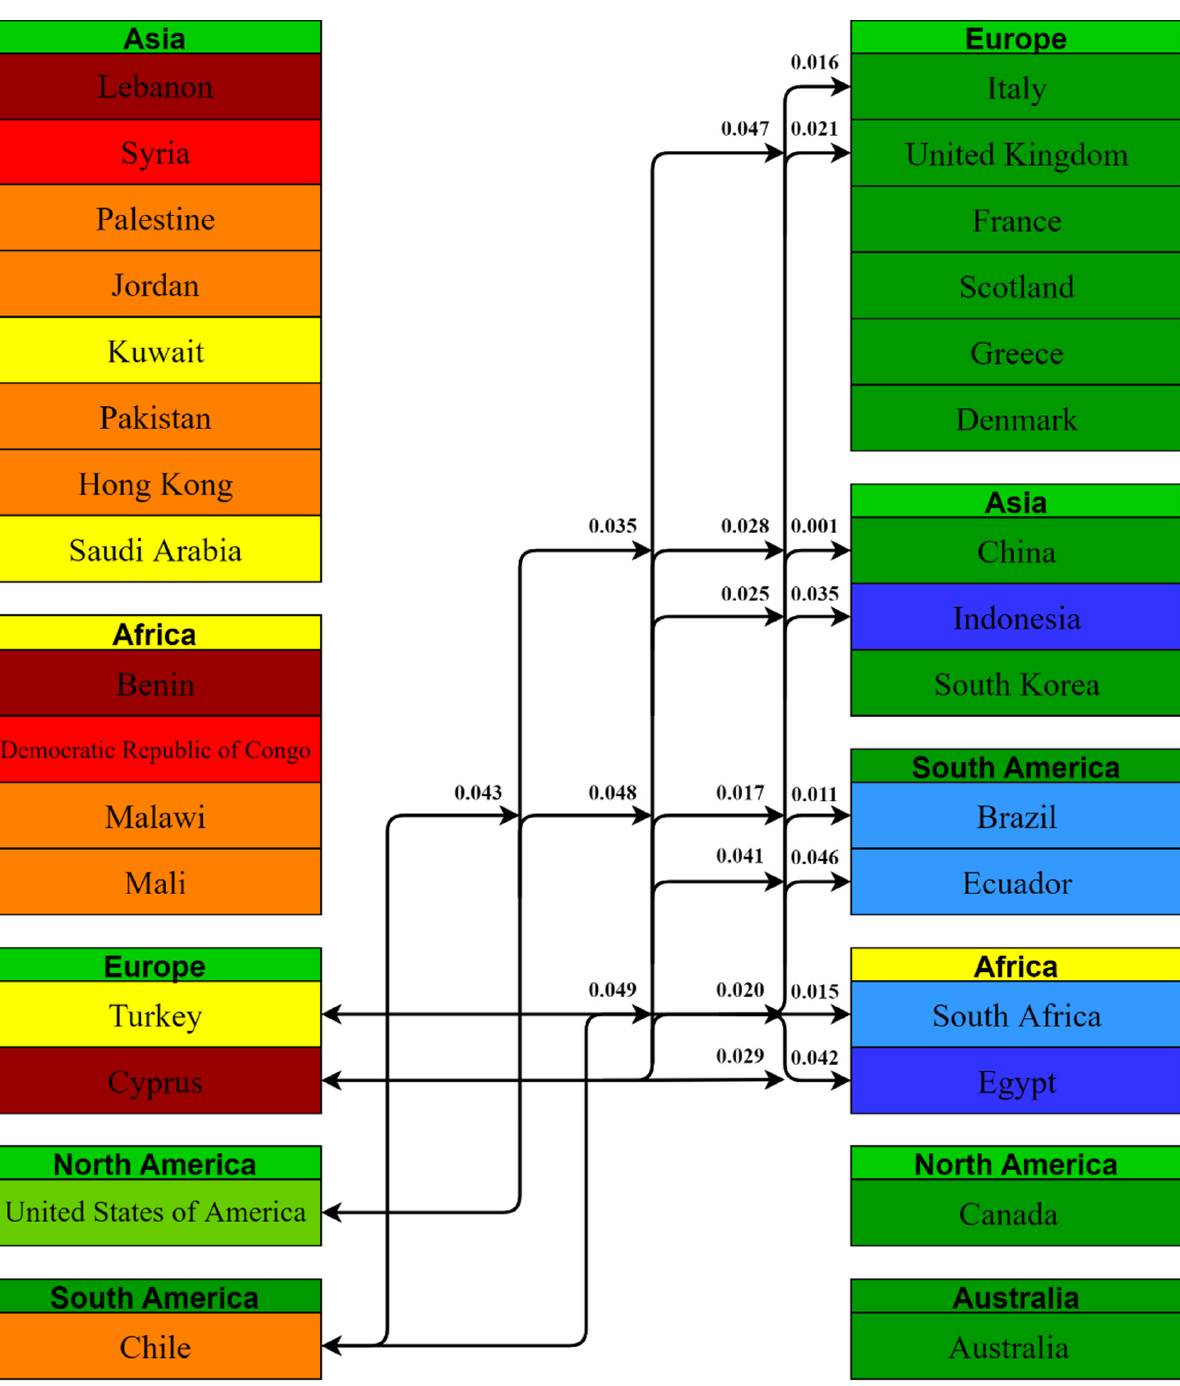
Figure 7. Pairwise comparison between European, North and South American countries having lesser acceptance rates with the rest of the world and their p values.